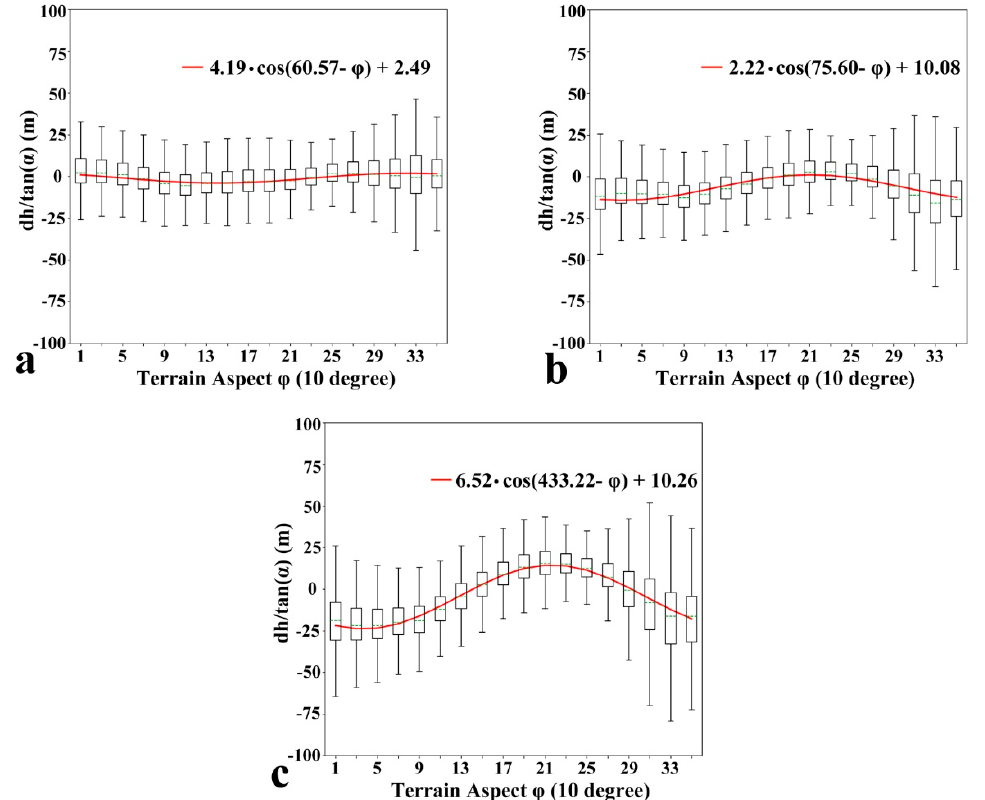
Figure 3. Variability of the elevation di ff erence (dh) standardized by the tangent of slope ( α ) with aspect ( ϕ ) in di ff erent co-registration combinations: ( a ) 2017NB ENM —SRTM-C; ( b ): 2017NF ENM —SRTM-C; ( c ) 2017BF ENM —SRTM-C. The ZY-3 DEM was registered to the SRTM-C DEM. The red line shows the corresponding fitting function as defined by Equation (3).